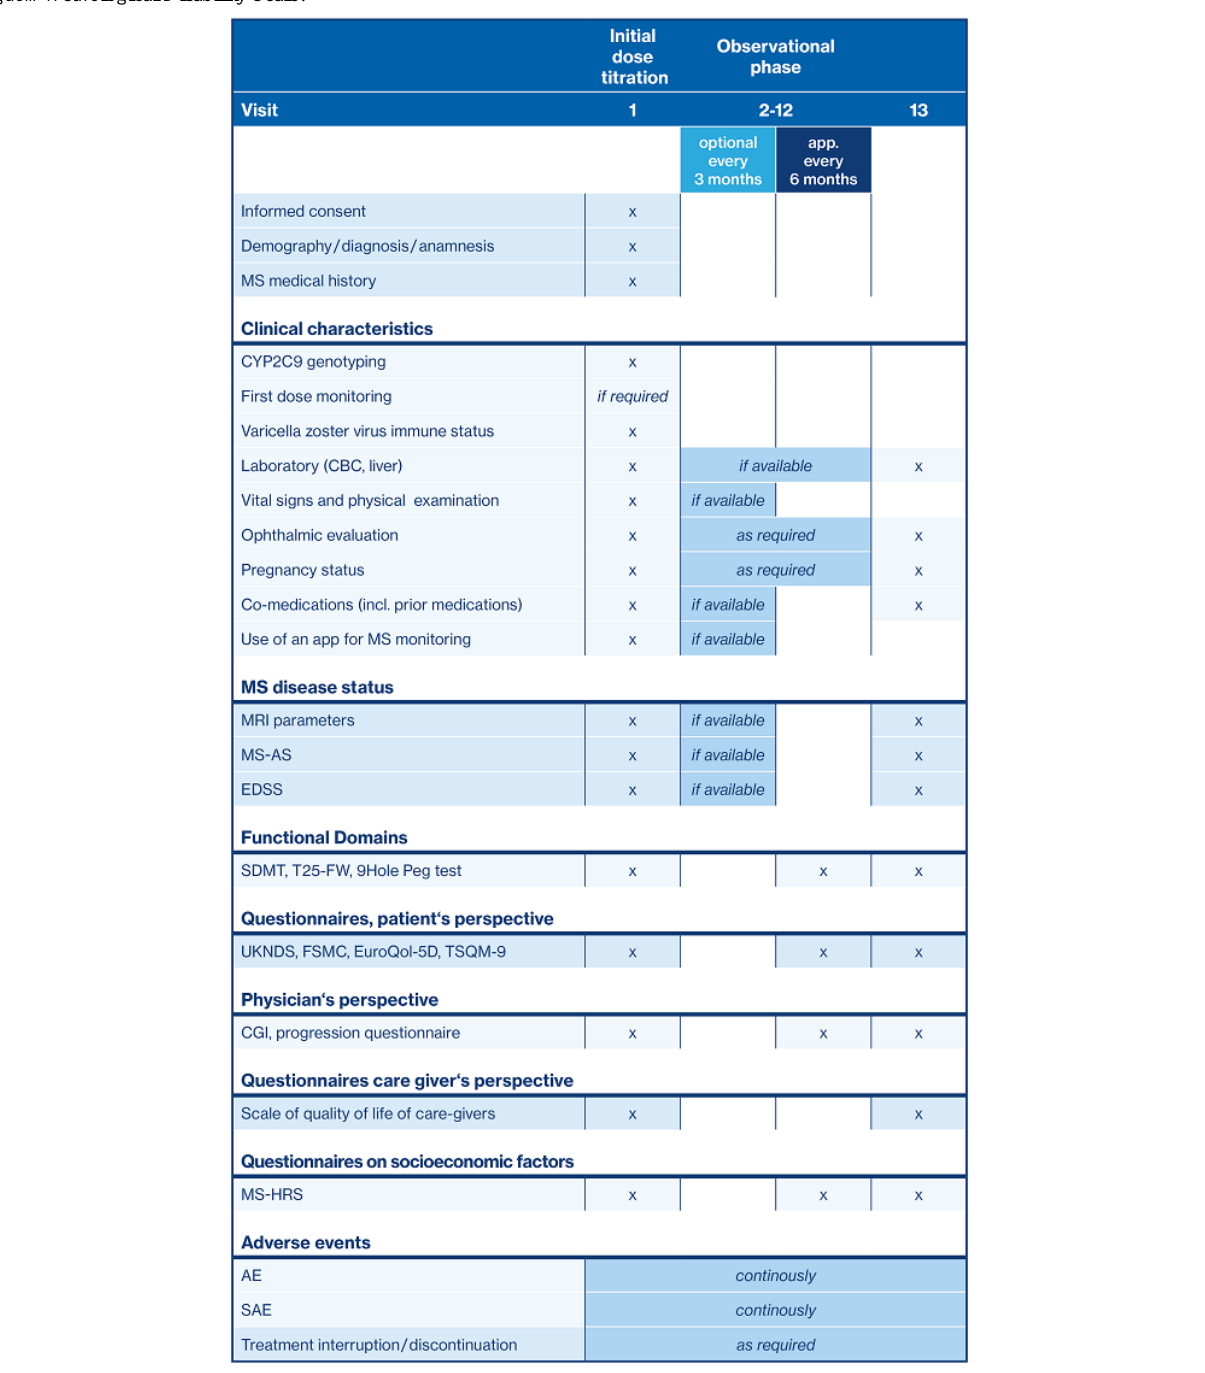
Figure 3. Study visits during AMASIA (imp A ct of M ayzent [siponimod] on second A ry progressive multiple S clerosis patients in a long-term non- I nterventional study in Germ A ny). 9Hole Peg test: nine-hole peg test; AE: adverse event; CBC: complete blood count; CGI: clinical global impression; EDSS: Expanded Disability Status Scale; FSMC: Fatigue Scale For Motor And Cognitive Functions; MRI: magnetic resonance imaging; MS: multiple sclerosis; MS-AS: MS activity scale; MS-HRS: Multiple Sclerosis Health Resource Utilization Survey; SAE: serious adverse event; SDMT: symbol digit modalities test; T25-FW: timed 25-foot walk; TSQM-9: Treatment Satisfaction Questionnaire for Medication; UKNDS: United Kingdom Neurological Disability